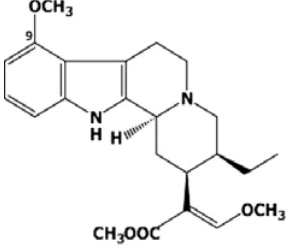
Figure 1. Structure of